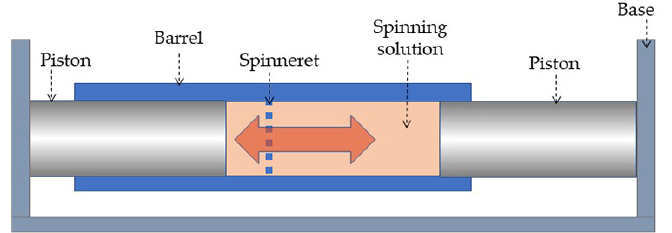
Figure 1. Scheme of the laboratory opposing mixer.